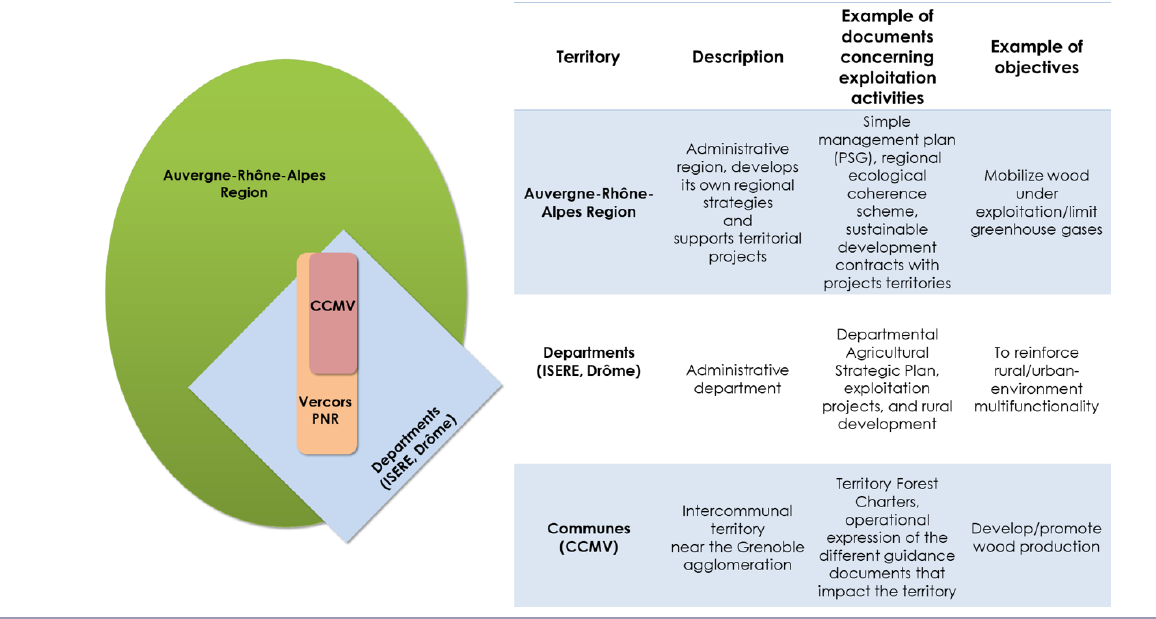
Fig. 2 . Schema representing the different entities involved in the governance of the forest. Orange rectangle represents the Vercors regional natural park (PNR) where it is partly governed by three entities. Regional governance, which is represented by a green circle and its administration occupy all the PNR. Departmental governance represented by a light blue square where the jurisdiction resides almost on all the PNR. Communal governance represented by a pink rectangle inside the PNR. Although the jurisdiction overlaps, the three entities share different objectives and authority in the